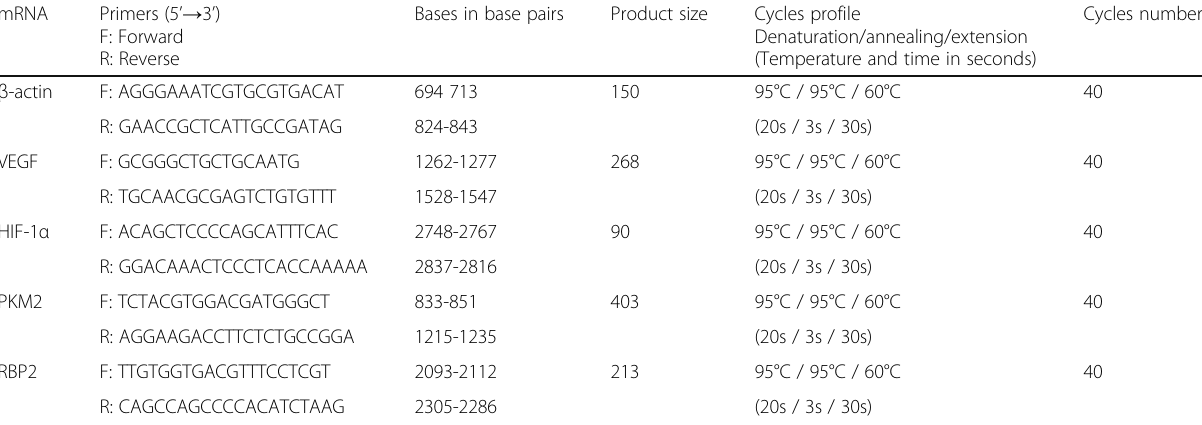
Table 1 Sequences of oligonucleotide primers and details of polymerase chain reactions